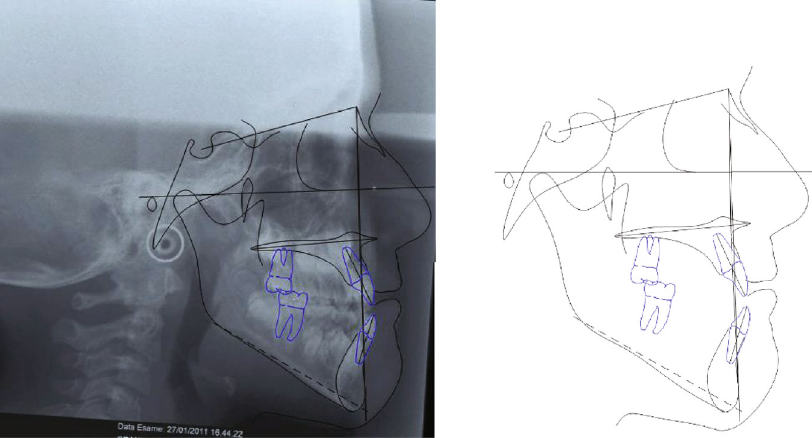
Figure 11: Case no. 2 tracings